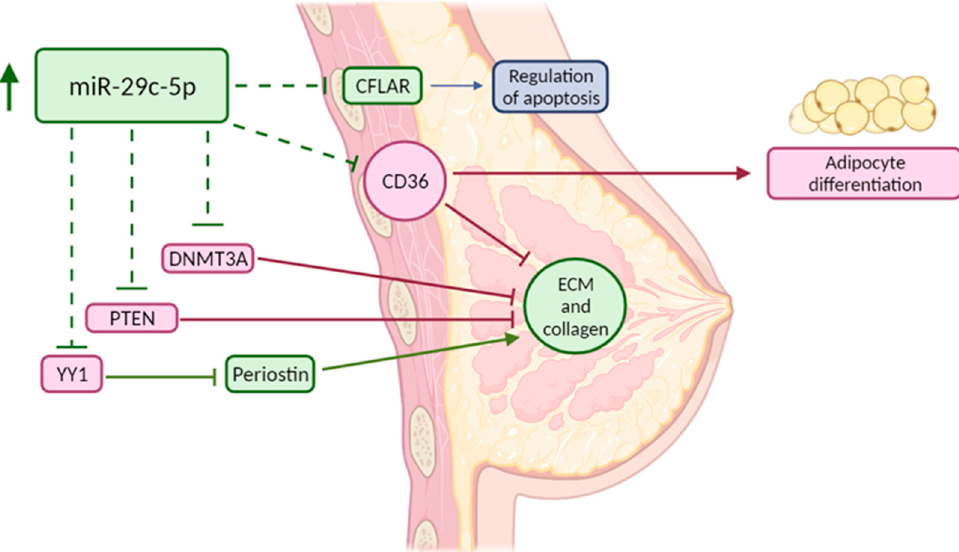
Figure 3. Graphical overview of miRNA–mRNA target interactions possibly related to the development of high mammographic density based on this study. Green targets and pathways are upregulated whereas red targets and pathways are downregulated, blue is an effect of the target. Created with BioRender.com. CFLAR = CASP8 and FADD-like apoptosis regulator; DNMT3A = DNA methyltransferase 3A; ECM and collagen = ECM organization and collagen deposition; PTEN = phosphatase and tensin homolog; YY1 = Yin Yang 1.